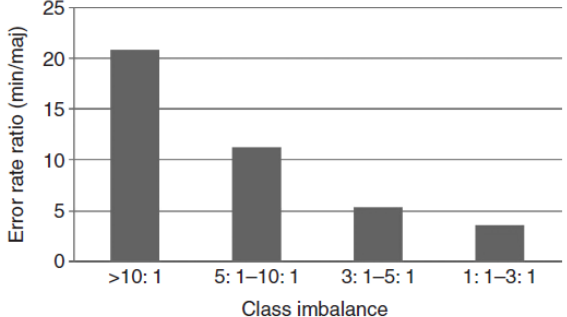
Figure 5. Impact of class imbalance on classification performance of minority class